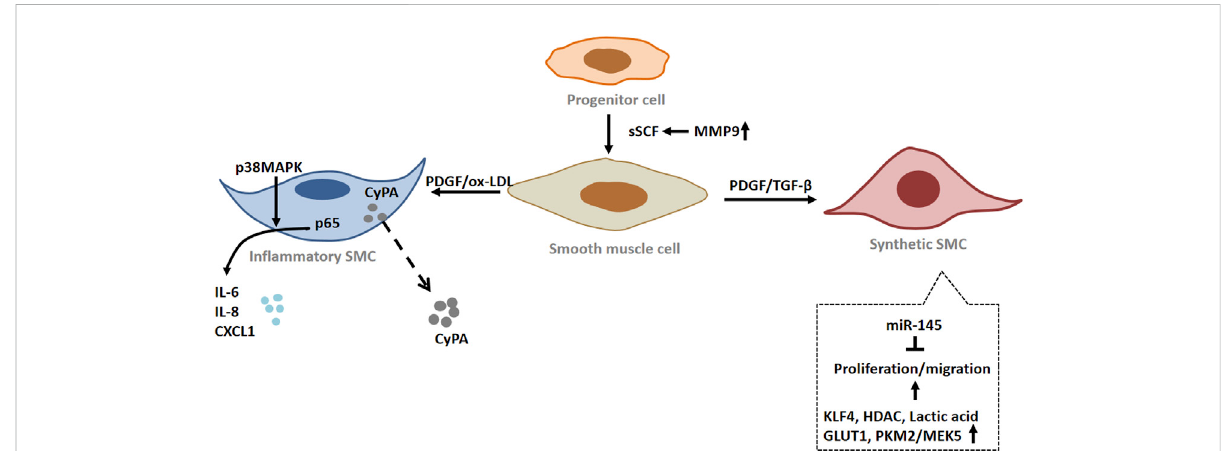
FIGURE 3 Theroleofsmoothmusclecells(SMCs)inperipheralarterialdisease(PAD).Underpathologicalconditions,smoothmusclecells(SMCs)undergo phenotypicswitching. The proliferation and migration of SMC with synthetic phenotype wereenhanced. In fl ammatory SMCs produce and secretea variety of in fl ammatory factors. When blood vessels are injured, vascular progenitor cells become activated and differentiate into SMCs. Abbreviations: SCF, stem cell factor; MMP9, matrix metalloproteinase 9; PDGF, platelet derived growth factor; IL-6, interleukin-6; IL-8,